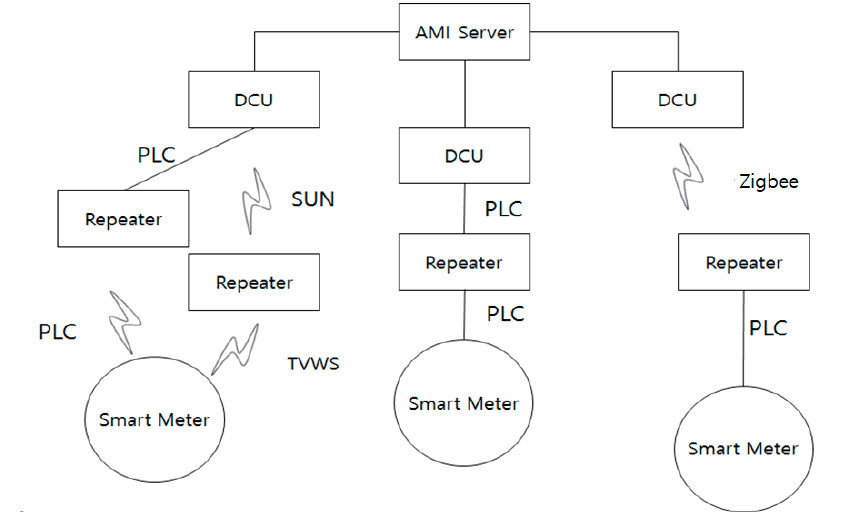
Figure 1. Hybrid Advanced Metering Infrastructure Structure.